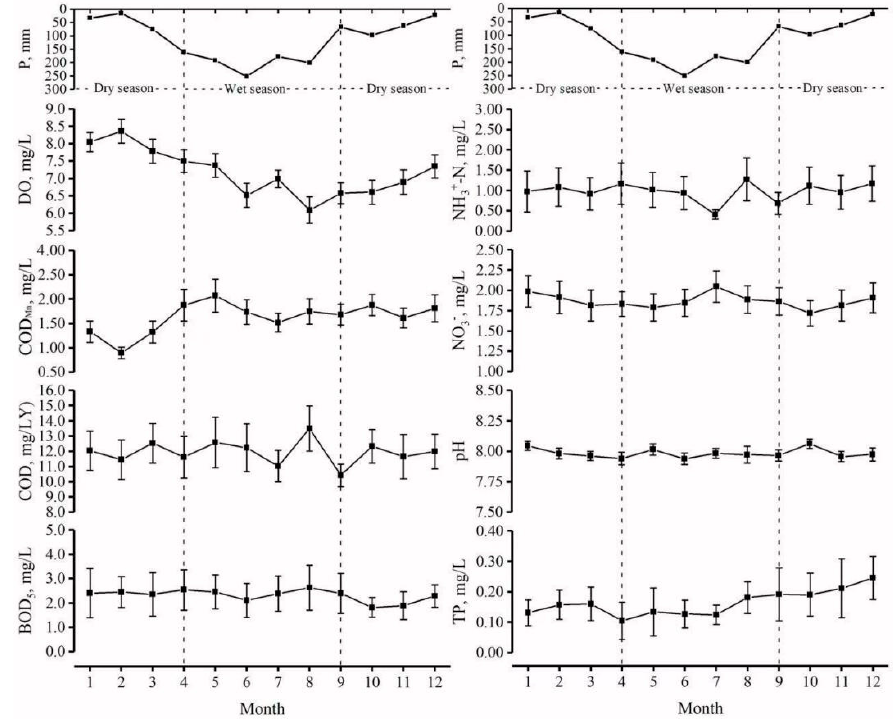
Figure 2. Mean values of eight water quality indicators from 2014 to 2017 during wet and dry seasons.